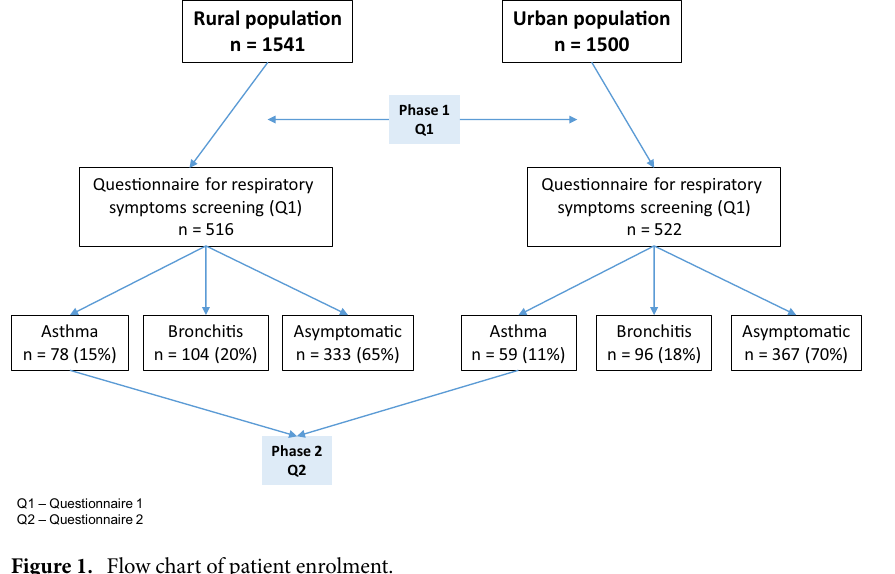
Figure 1. Flow chart of patient